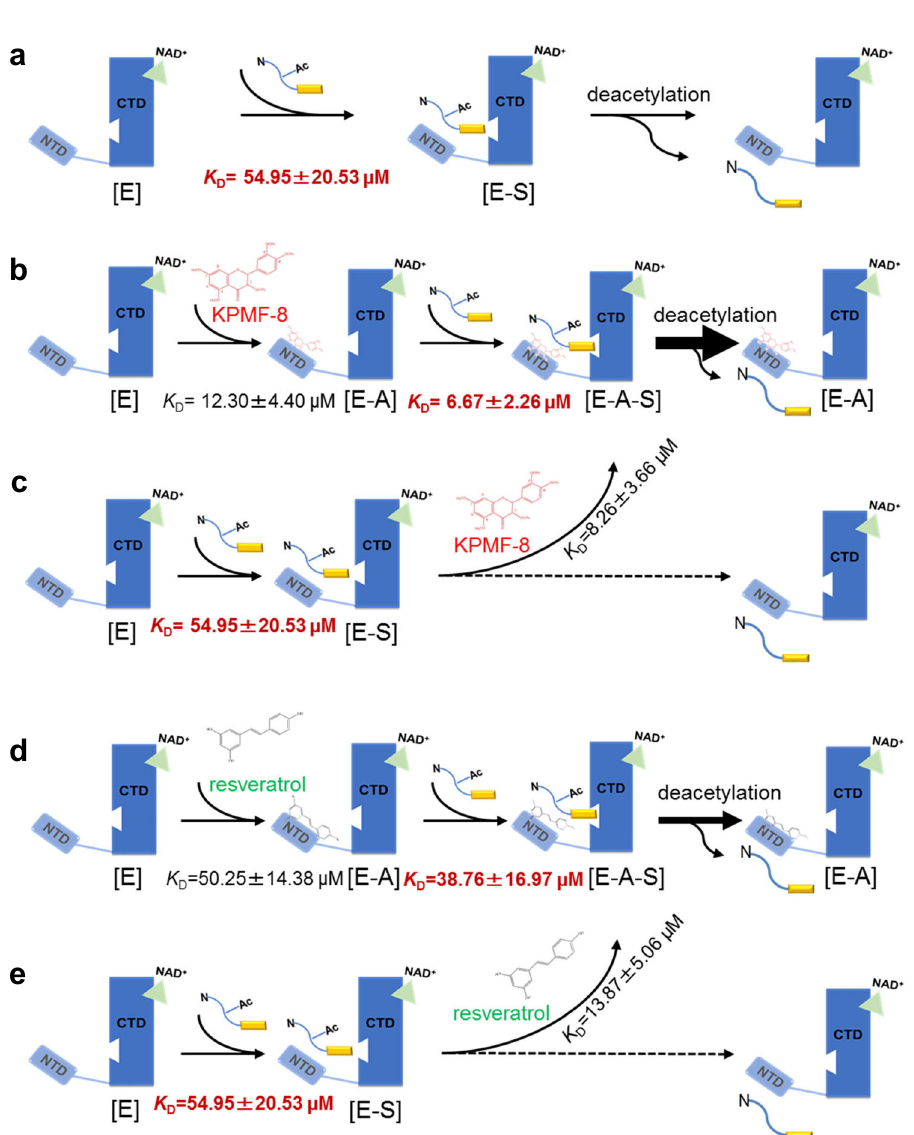
Fig. 10 Proposed mechanism for SIRT1 activation by KPMF-8 and resveratrol. a , b , d The binding of SIRT1 [E] and Ac-p53 peptide [S] in the absence of an activator, in the presence of KPMF-8 and in the presence of resveratrol. b , c The binding of KPMF-8 to SIRT1 [E] and SIRT1 – Ac-p53 peptide [E – S] complex. d , e The binding of resveratrol to SIRT1 [E] and SIRT1 – Ac-p53 peptide [E – S]